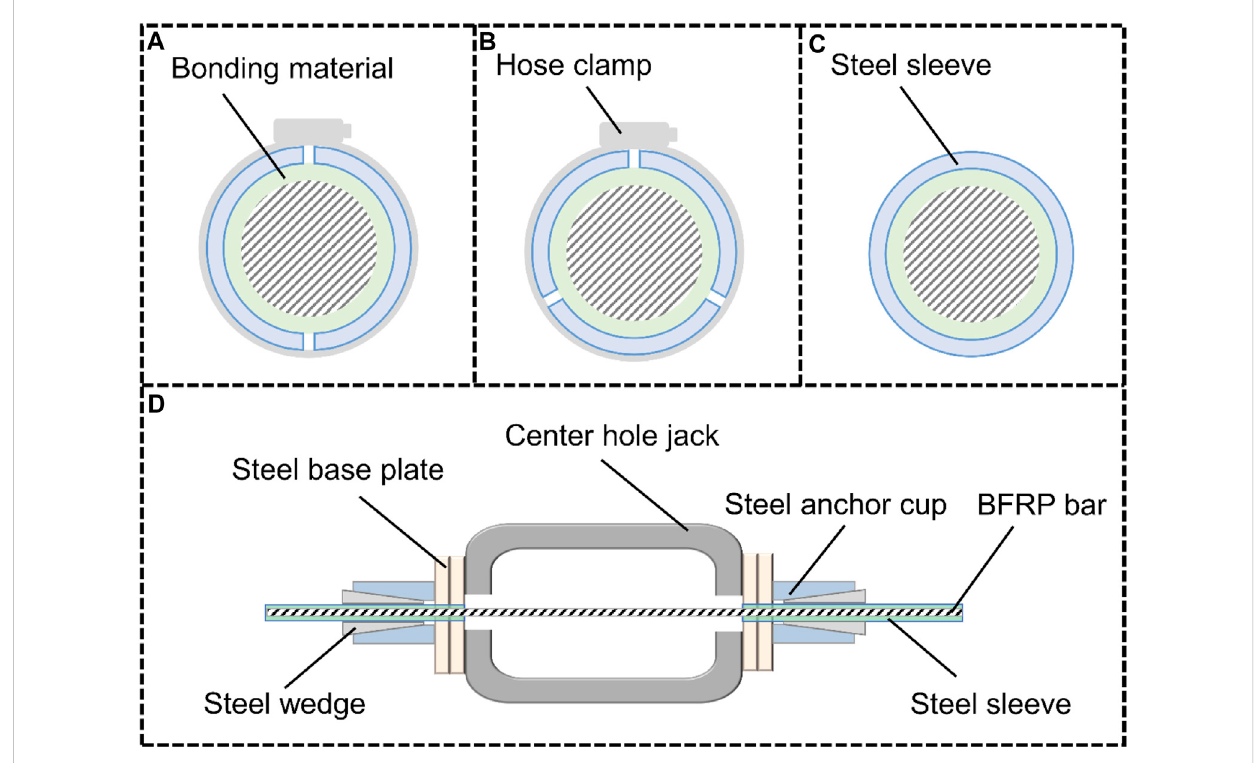
FIGURE 3 Cross-sectional view of bonded structures and the tension device of the SBAS: (A) Bivalve steel sleeve, (B) Trivalve steel sleeve, (C) seamless steel sleeve, (D) Tension device of the SBAS.